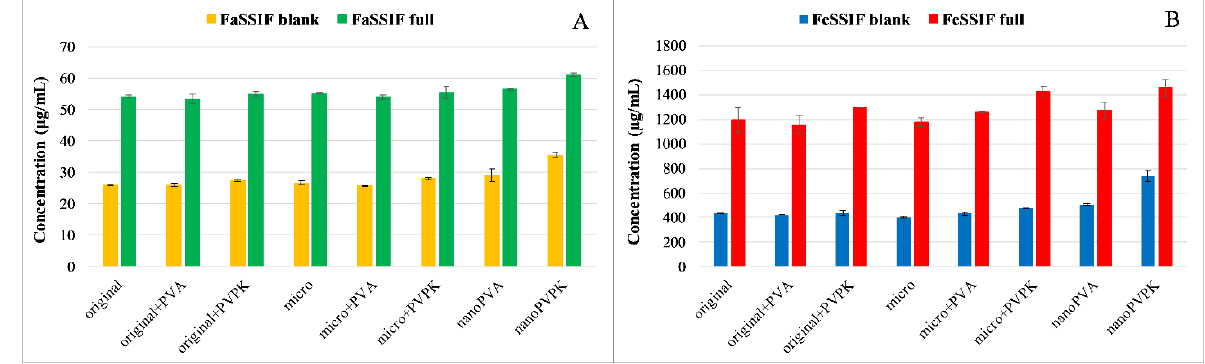
Figure 1. The solubility results of papaverine hydrochloride in pH = 6.5 ( A ) and pH = 5.0 ( B ) me- dia.